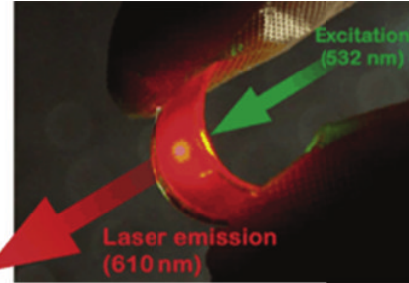
Figure 18: Laser effect of the plastic film